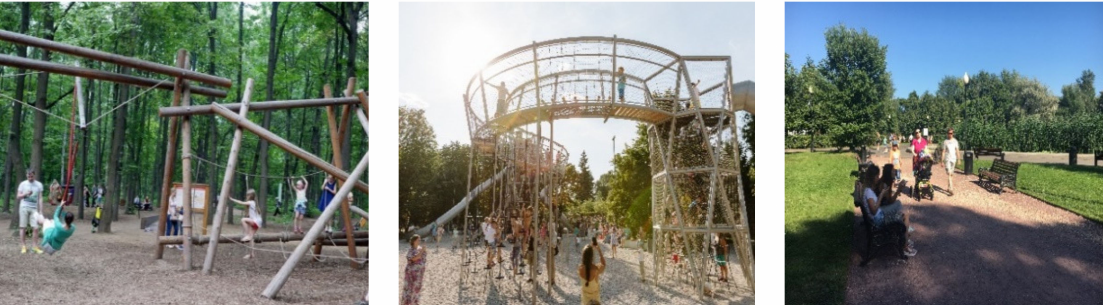
Figure 7. UGS use for breathing fresh air, relaxing, and escaping from the crowded city (Photos: D. Dushkova, A. Konstantinova).